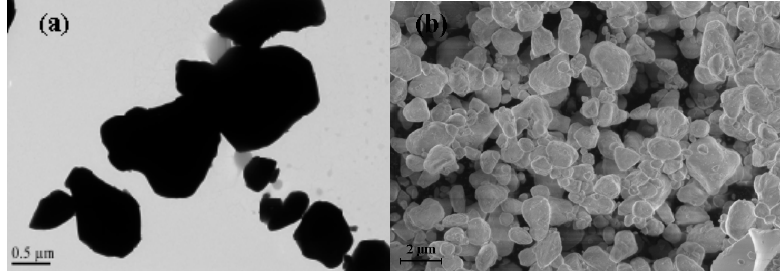
Figure 5. ( a ) TEM image of BiGdO 3 ; and ( b ) SEM image of BiGdO 3 .